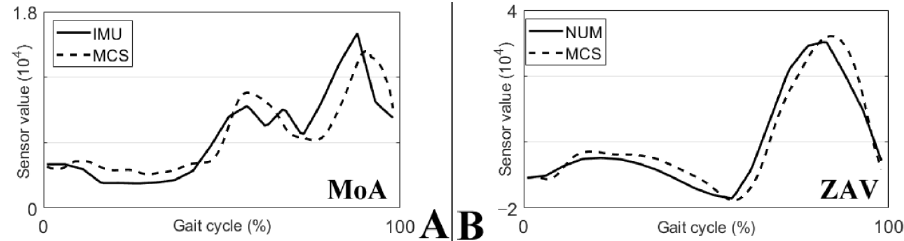
Figure 4. Experimental results of joint angle converting. ( A ) Plotted MoA of the IMU and MCS. ( B ) Plotted ZAV of the IMU and MCS.